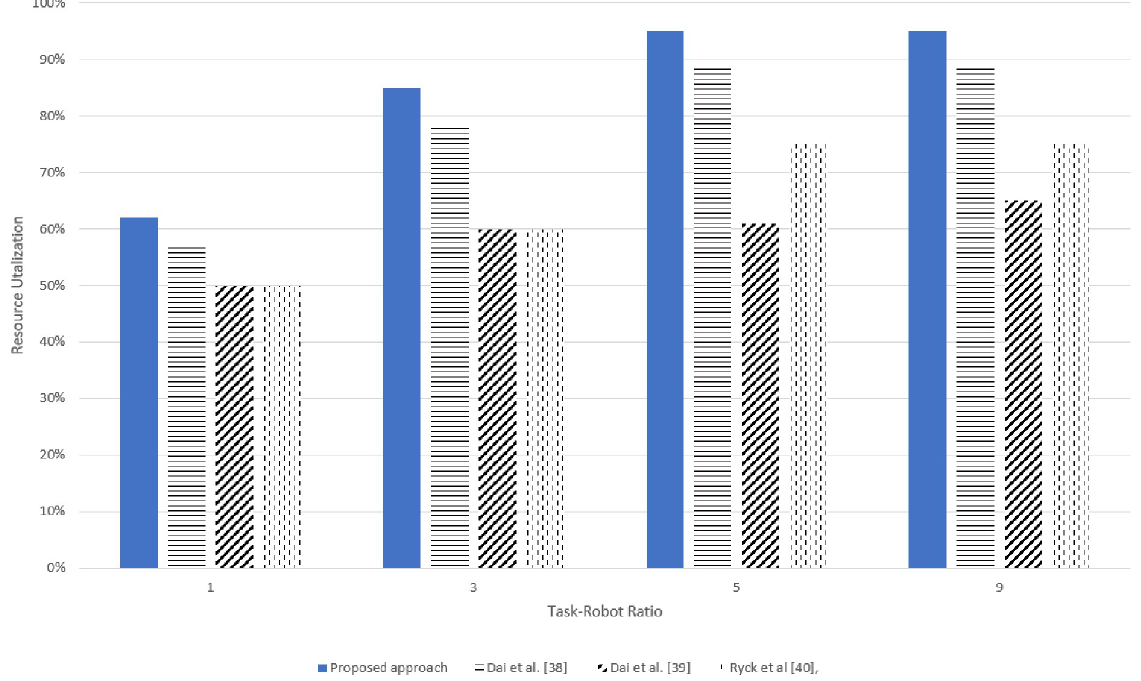
Fig 13. Simulation results for resource utilization for various task-robot ratio.